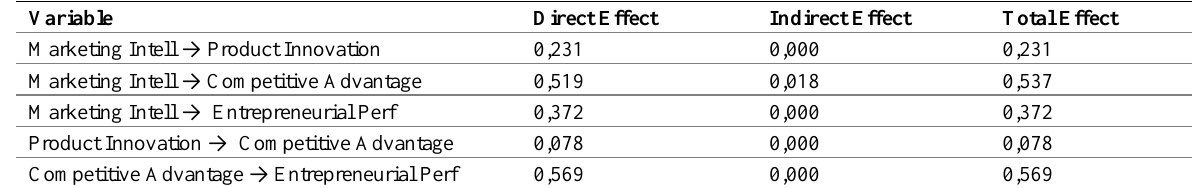
Table 9: Standardized Direct, Indirect and Total Effects